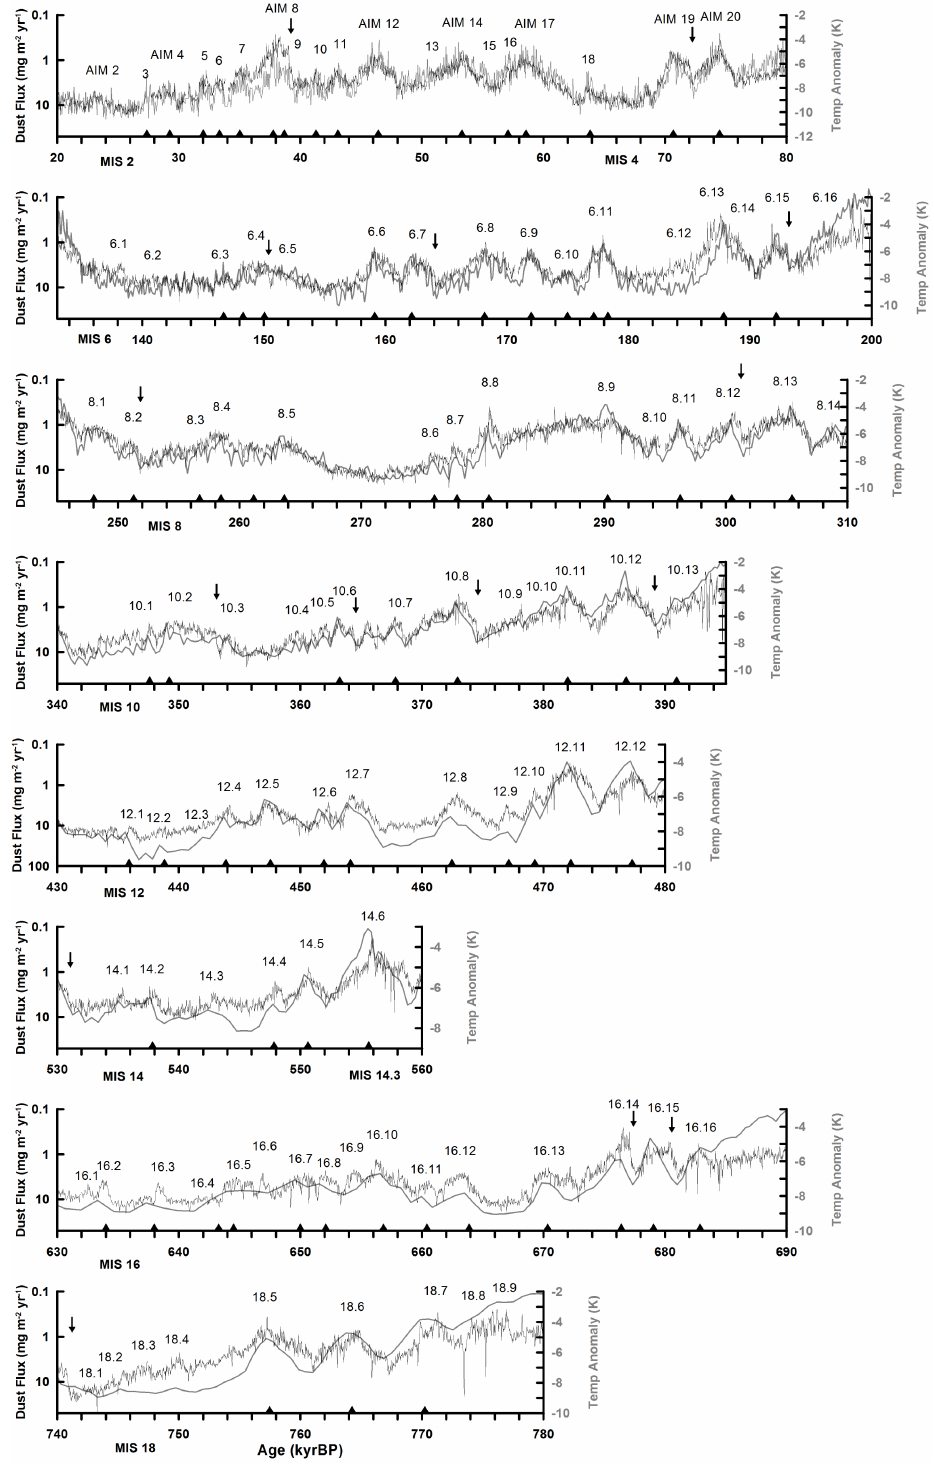
Fig. 4. 25 year mean dust flux data in black underlain with the EDC temperature data at original 55cm depth resolution (Jouzel et al., 2007) back to 800kyrBP. Antarctic Isotopic Maxima (AIM) during the last glacial are marked as identified in EPICA comm. Members(2006). Previous warming/low dust events as detected in our high-resolution dust record have been consecutively numbered according to their Marine Isotope Stage. Vertical arrows mark the rapid dust flux jumps. The triangles mark the predicted occurrence of DO events based on the EDC δ D data (Barker et al.,